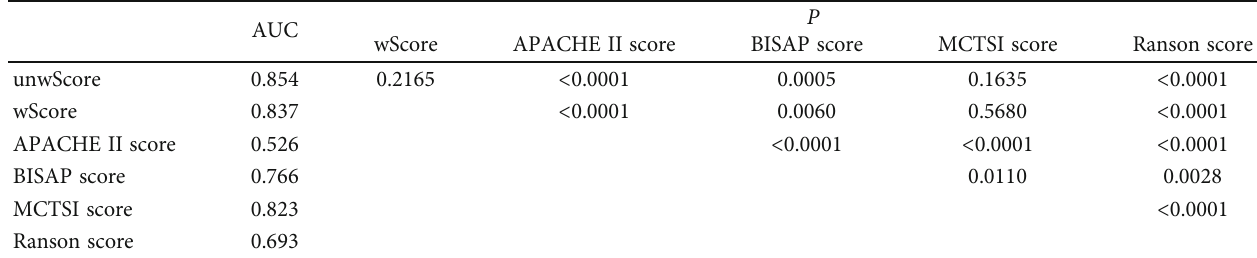
Table 5: Comparison of the area under the ROC curve of the unweighted prediction model, the weighted prediction model, and the severity score in predicting MSAP and SAP.